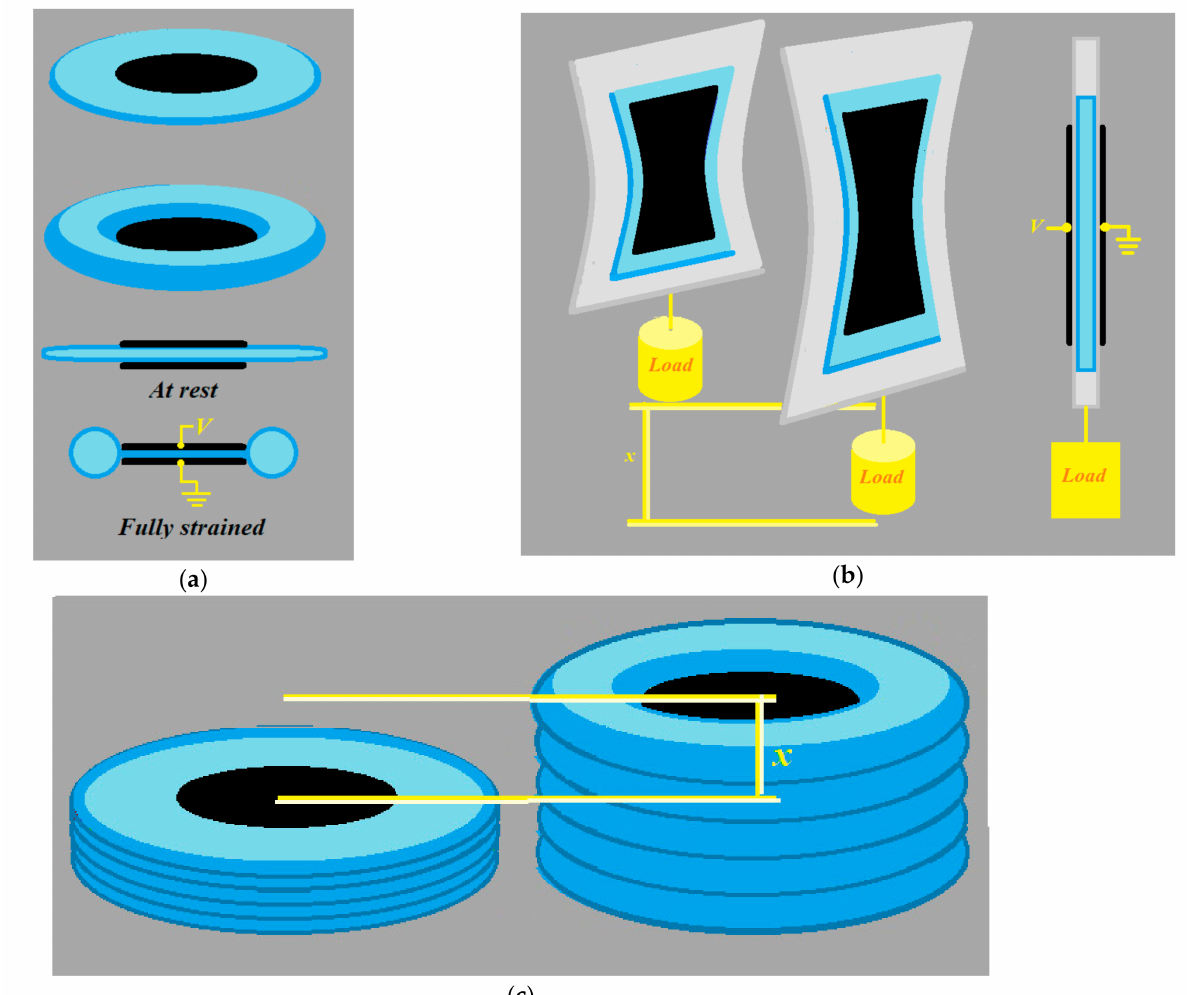
Figure 1. ( a ) The design for the donut actuator; ( b ) the design for the stretchable planar [1] HASEL (Hydraulically amplified self-healing electrostatics) actuator; ( c ) the strain achieved by 5 donut HASEL actuators stacked on top of each